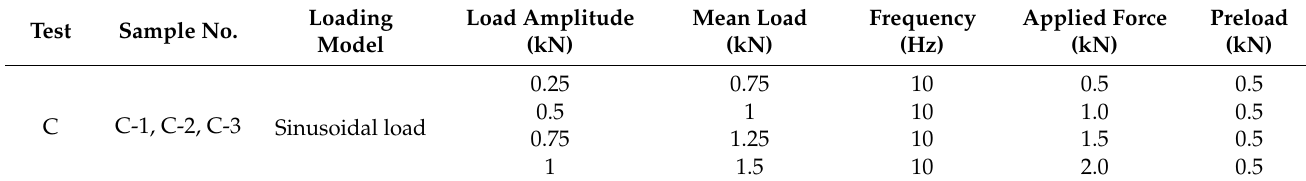
Table 8. Loading scheme of Test C.